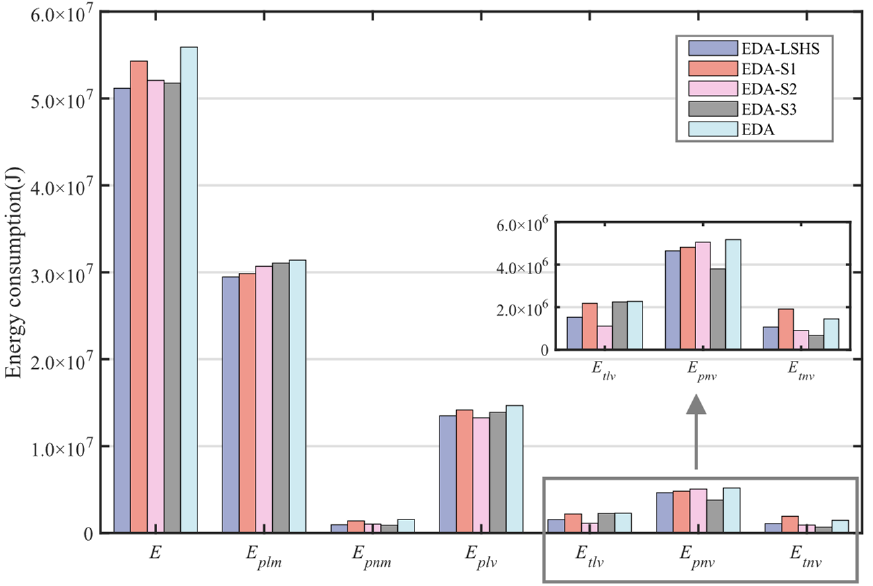
Figure 11. The optimization results of different types of energy consumption for Product 4.